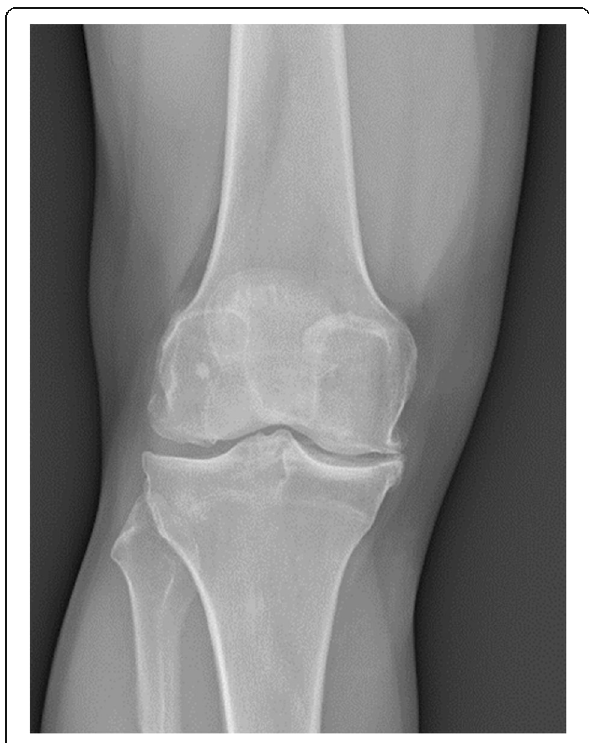
Fig. 1 Pre-operative AP knee radiography Patient 1